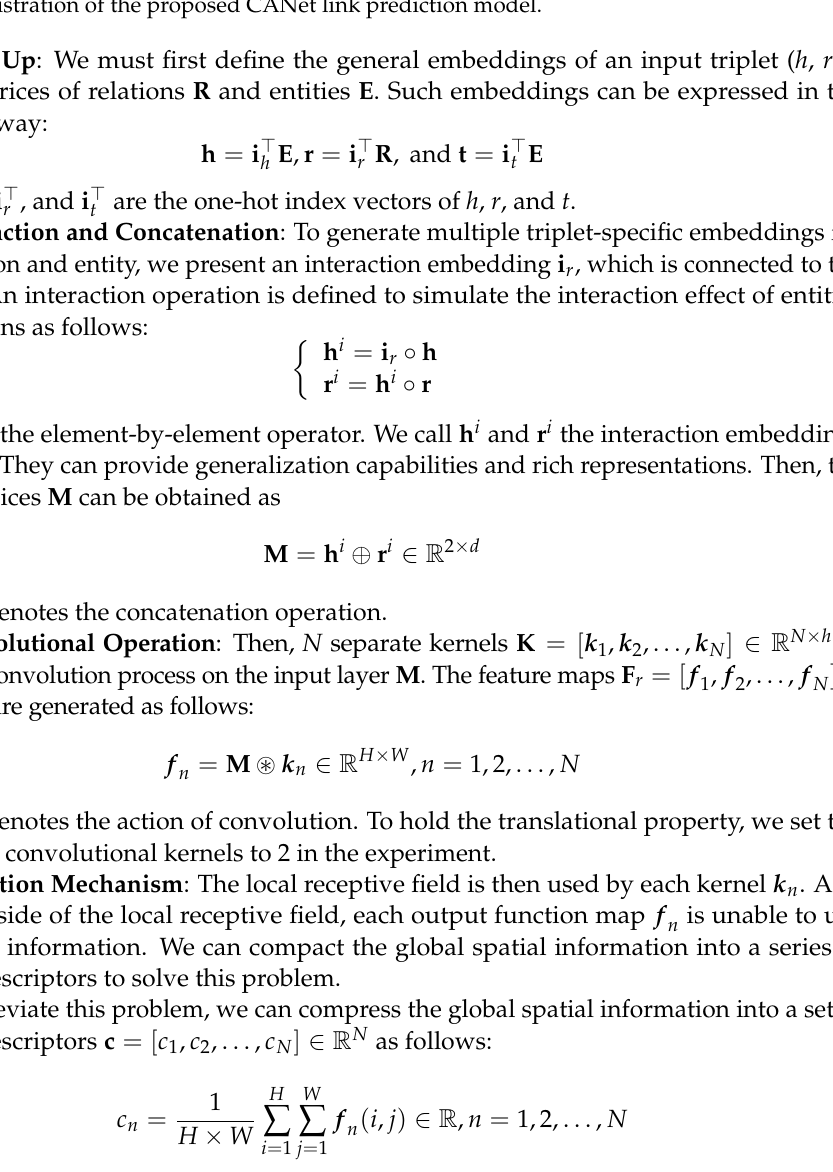
Figure 2. Illustration of the proposed CANet link prediction